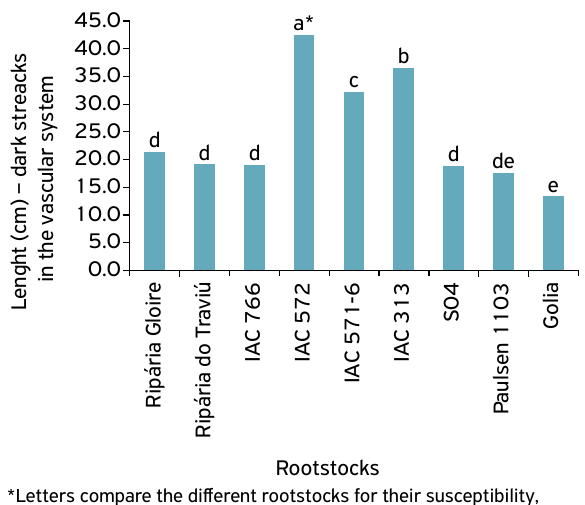
Figure 2. Susceptibility of vine rootstocks to the fungus Phaeomoniella chlamydospora .